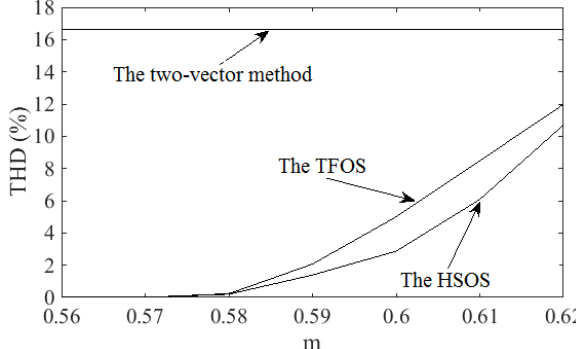
Figure 11. THD value of phase-A voltage in